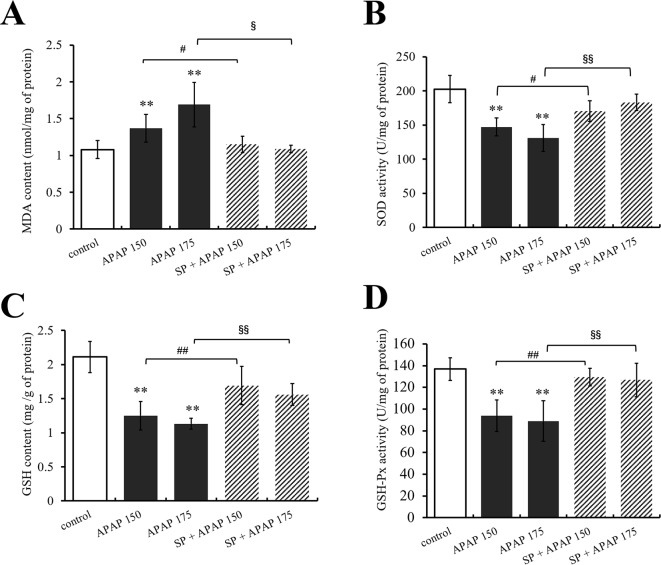
Changes of oxidative stress under different dosages of APAP in liver of mice with or without SP600125. (A) Change of MDA content under different dosages of APAP in liver of mice with or without SP600125. (B) Change of SOD activity under different dosages of APAP in liver of mice with or without SP600125. (C) Change of GSH content under different dosages of APAP in liver of mice with or without SP600125. (D) Change of GSH-Px activity under different dosages of APAP in liver of mice with or without SP600125. Values represented as means ± SD, n = 6. *Represents statistical differences caused by APAP. #Represents statistical differences caused by SP600125 under 150 mg·kg−1 APAP. §Represents statistical differences caused by SP600125 under 175 mg·kg−1 APAP. 0.05 > P > 0.01 (#, §). P < 0.01 (**, ##, §§).